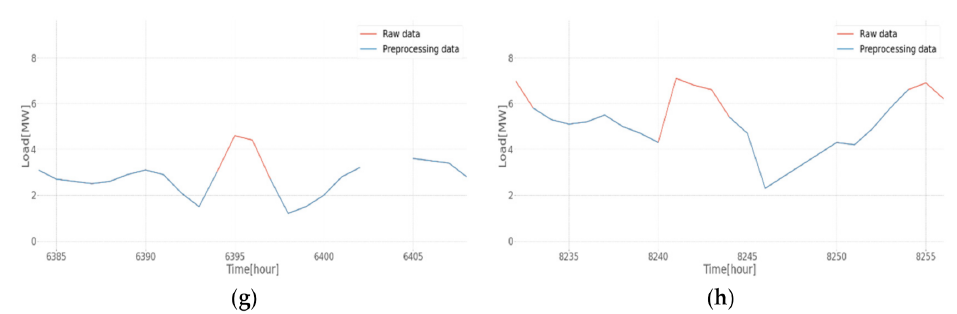
Figure 11. The load transfer detection results in Cheongyang DL using proposed methods: ( a ) The preprocessing results in 2019; ( b ) 4 January 2019; ( c ) 14 February 2019; ( d ) 5 June 2019; ( e ) 7 June 2019; ( f ) 12 July 2019; ( g ) 24 September 2019; ( h ) 10 December 2019.